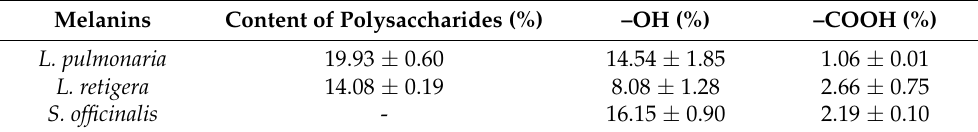
Table 2. The content of polysaccharides and –OH, –COOH functional groups in the melanins.